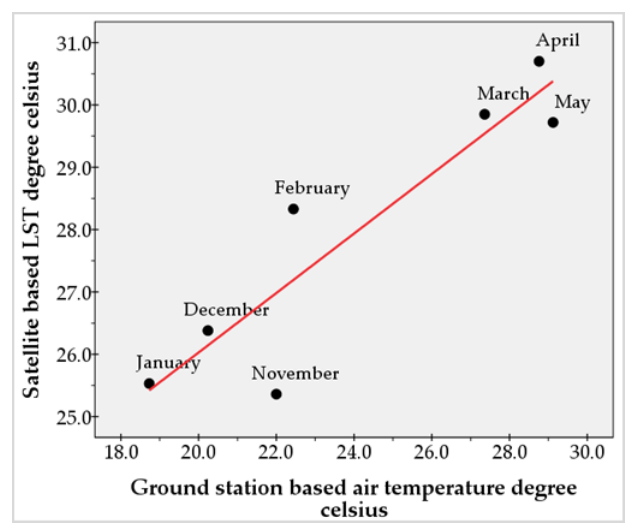
Figure 16. Ambient air temperature (Tair) based on a meteorological station and LST measured from Landsat Operational Land Imager (OLI) Thermal Infrared Sensor (TIRS) band 10.